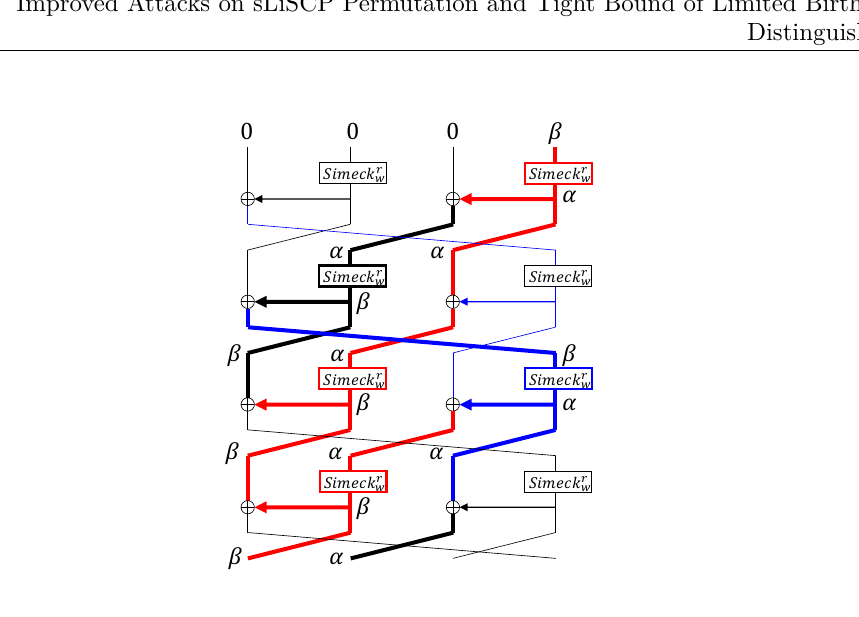
Figure 5: 4-Step Inbound Procedure for sLiSCP-light